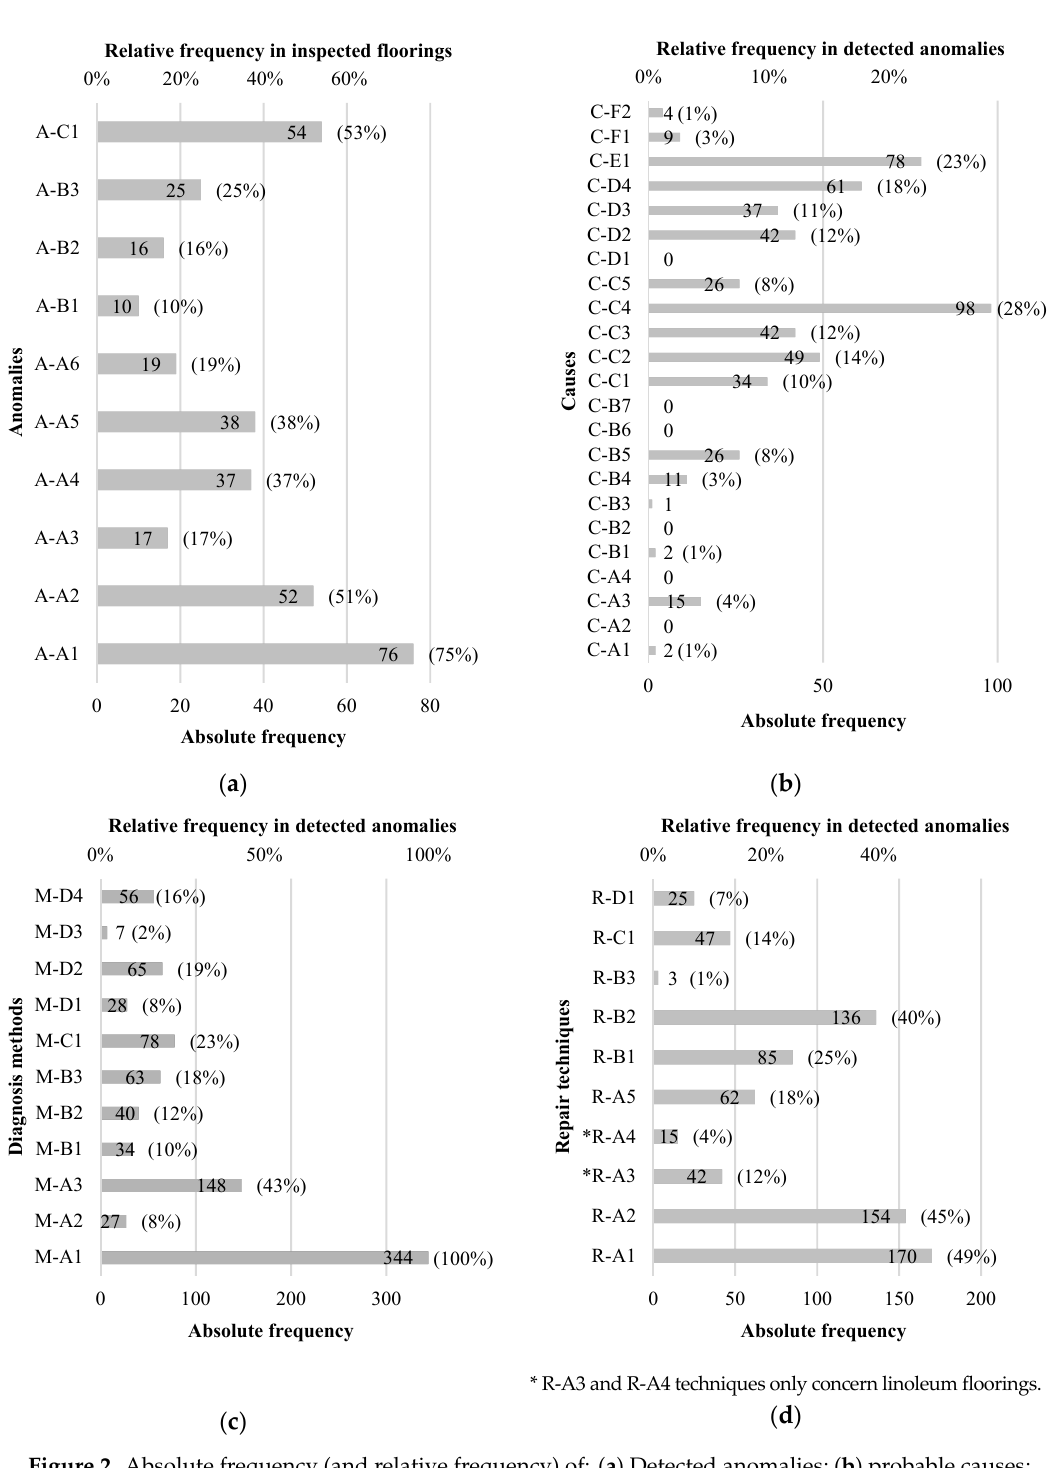
Figure 2. Absolute frequency (and relative frequency) of: ( a ) Detected anomalies; ( b ) probable causes; ( c ) adequate diagnosis methods; ( d ) recommended repair